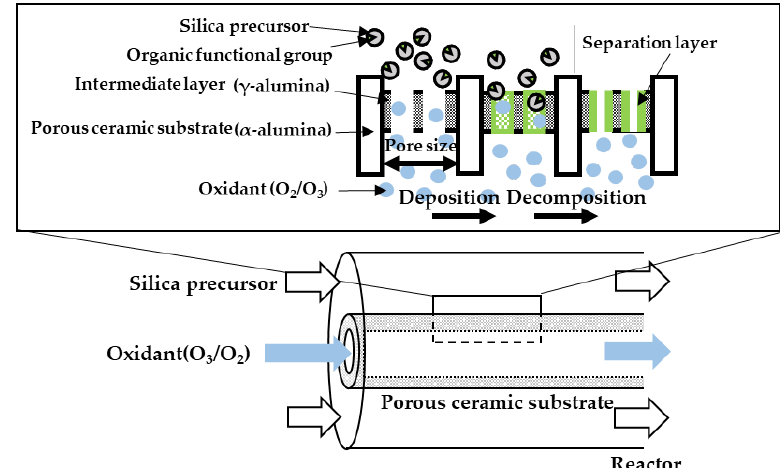
Figure 1. A schematic diagram of the counter diffusion chemical vapor deposition method.